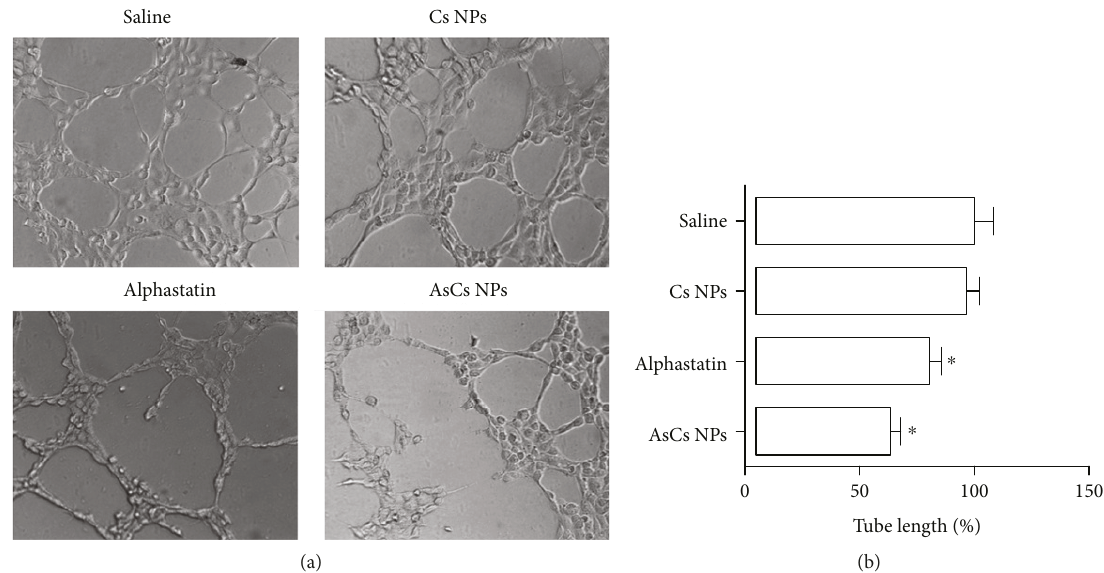
Figure 5: Impact of AsCs NPs on tube formation. (a) Representative images showing HUVEC tube formation under di ff erent nanoparticles at 100x magni fi cation. (b) Tube length index. ∗ P < 0 05 versus saline control.